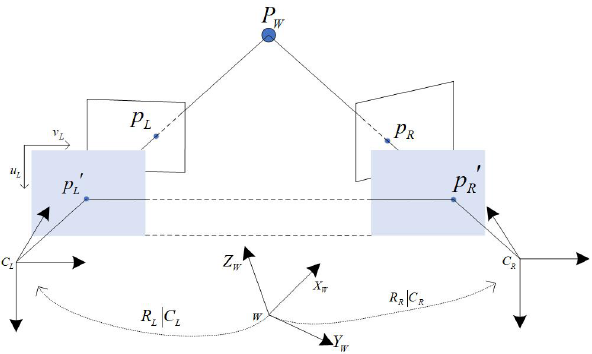
Figure 4. Schematic diagram of the camera projection